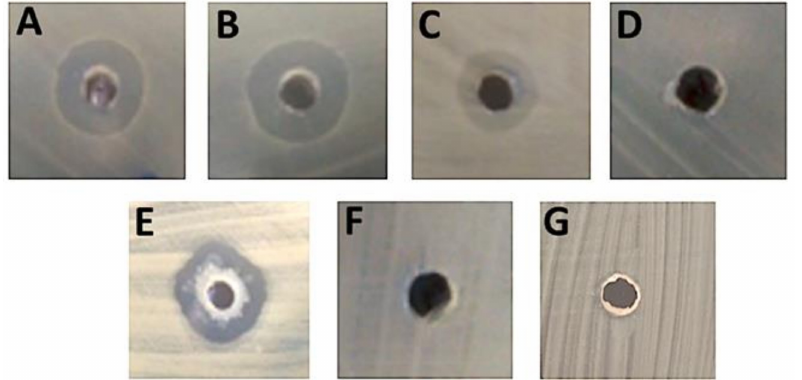
Figure 2. Inhibition of bacterial pathogens of fish species by GarKS cultured overnight on Mueller– Hinton agar plates. ( A ) Inhibition zone around Streptococcus agalactiae serotype Ia isolated from Nile tilapia ( Oreochromis niloticus ) in Taiwan, ( B ) inhibition zone around S. agalactiae serotype Ib from Nile tilapia in Taiwan, ( C ) inhibition zone around Aeromonas hydrophila strain 19 from rohu ( Labeo rohita ) in India and ( D ) no inhibition zone around Edwardsiella tarda from Olive flounder ( Paralichthys olivaceus ) in South Korea. ( E ) Note the presence of inhibition zone around Aeromonas salmonicida strain 6421 and the absence of inhibition zones around ( F ) A. salmonicida strain 6422 and ( G ) Yersinia ruckeri isolated from Atlantic salmon ( Salmo salar L). S. agalactiae , A. hydrophila and E. tarda were cultured at 37 ◦ C while A. salmonicida and Y. ruckeri were cultured at 25 ◦ C. For all bacterial species, 100 µ L of 10 7 CFU/mL bacterial suspension were spread on Mueller–Hinton agar plate while 50 µ L of 33 µ g/mL GarKS were put in the well at the centre of each plate.